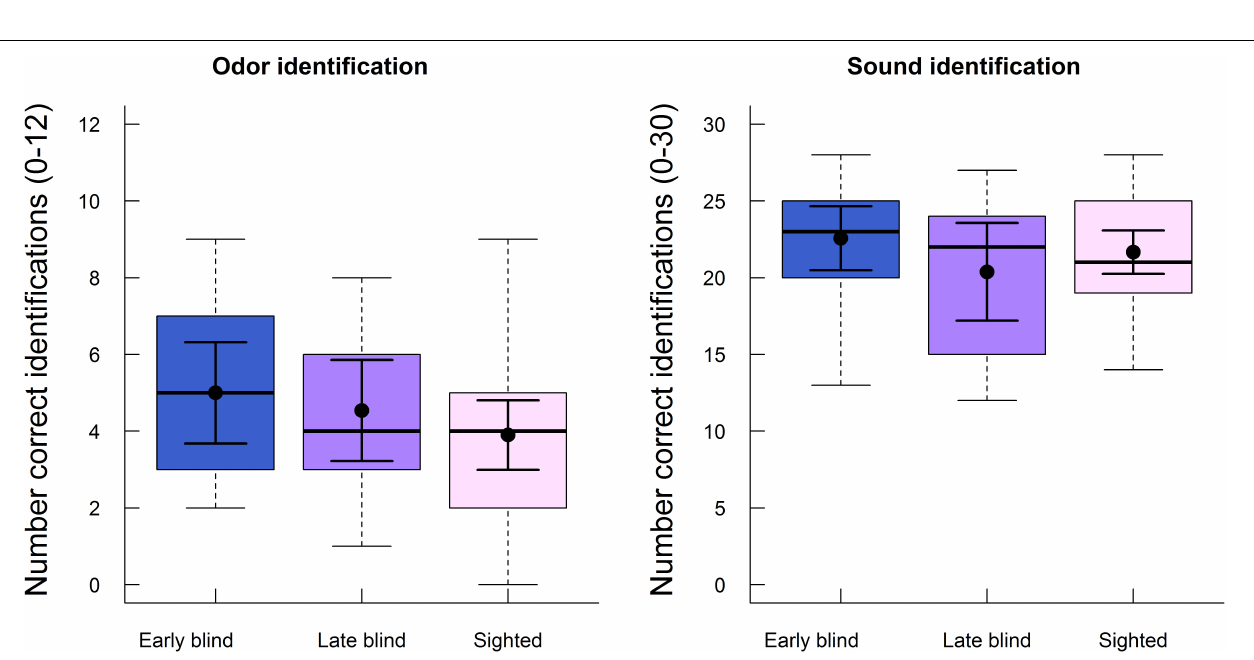
FIGURE 3 | Boxplots of episodic recognition performance ( d (cid:48) ) for odors (left panel) and sounds (right panel) at follow-up (T2) are displayed separately for early blind, late blind, and sighted participants. The boxes indicate the 25th, 50th (median), and 75th percentiles of the distribution (lower, middle, and upper horizontal lines of the box). The upper hinges indicate the maximum value of the variable located within a distance of 1.5 times the inter-quartile range above the 75th percentile. The lower hinges indicate the corresponding distance to the 25th percentile value. The means and 95% confidence intervals (dots and error bars in solid lines) are superimposed on the boxplots.